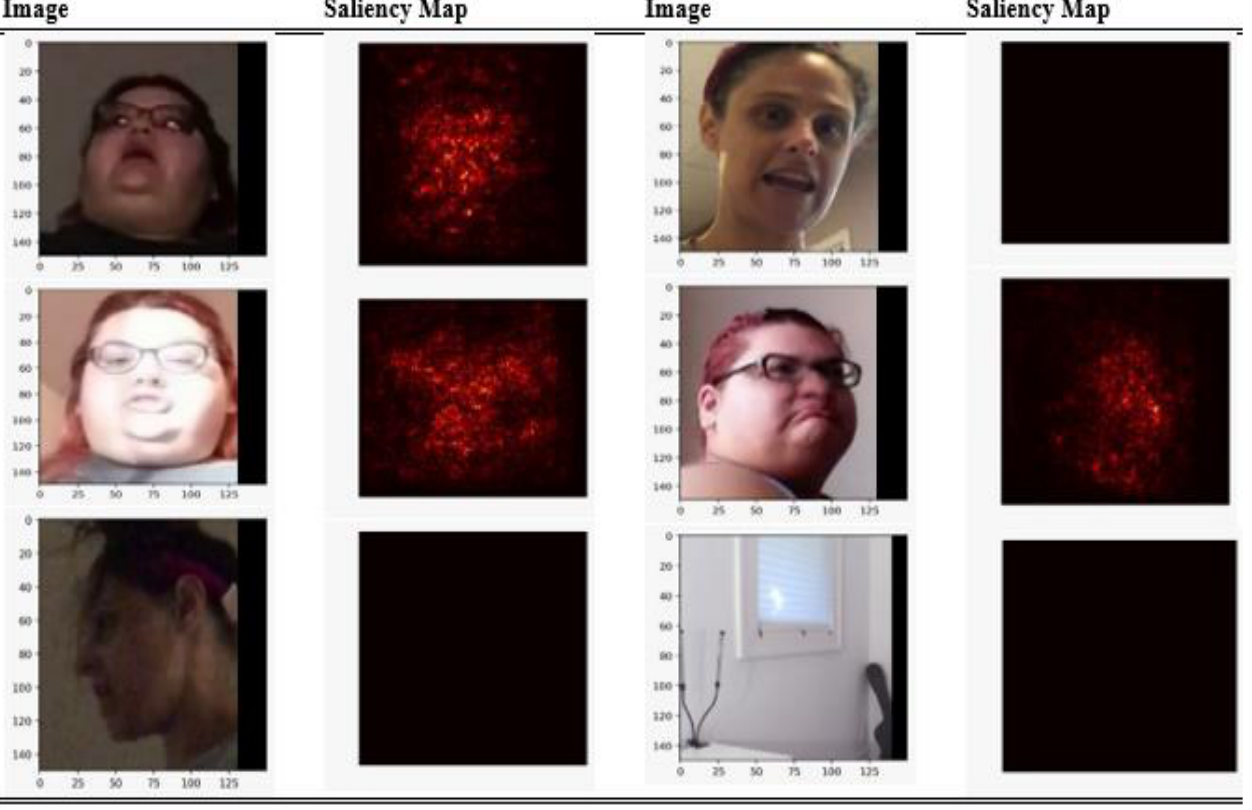
Figure 8. Saliency map of various images.